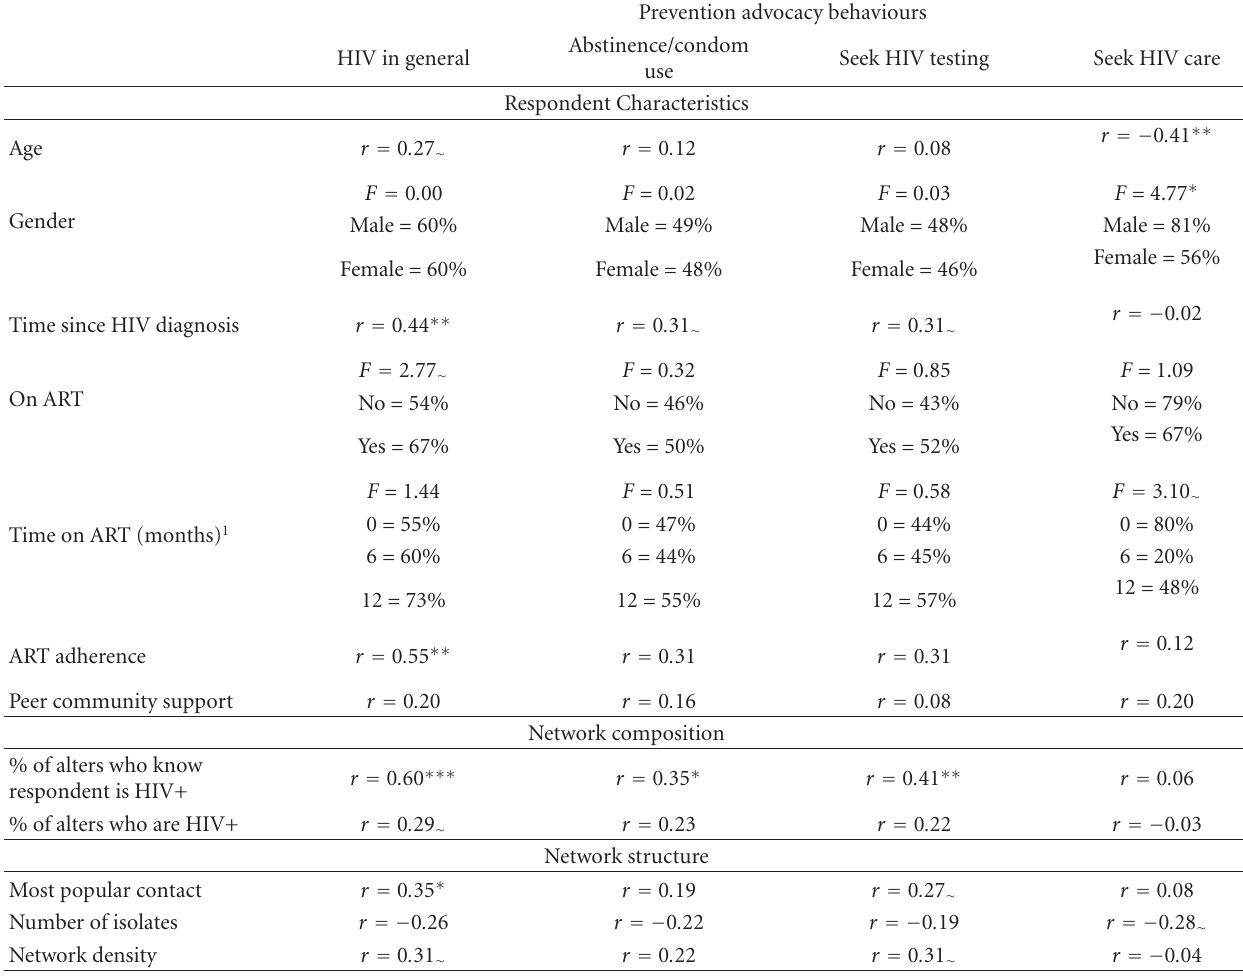
Table 1: Correlates of engagement in prevention advocacy behaviours with proportion of network members